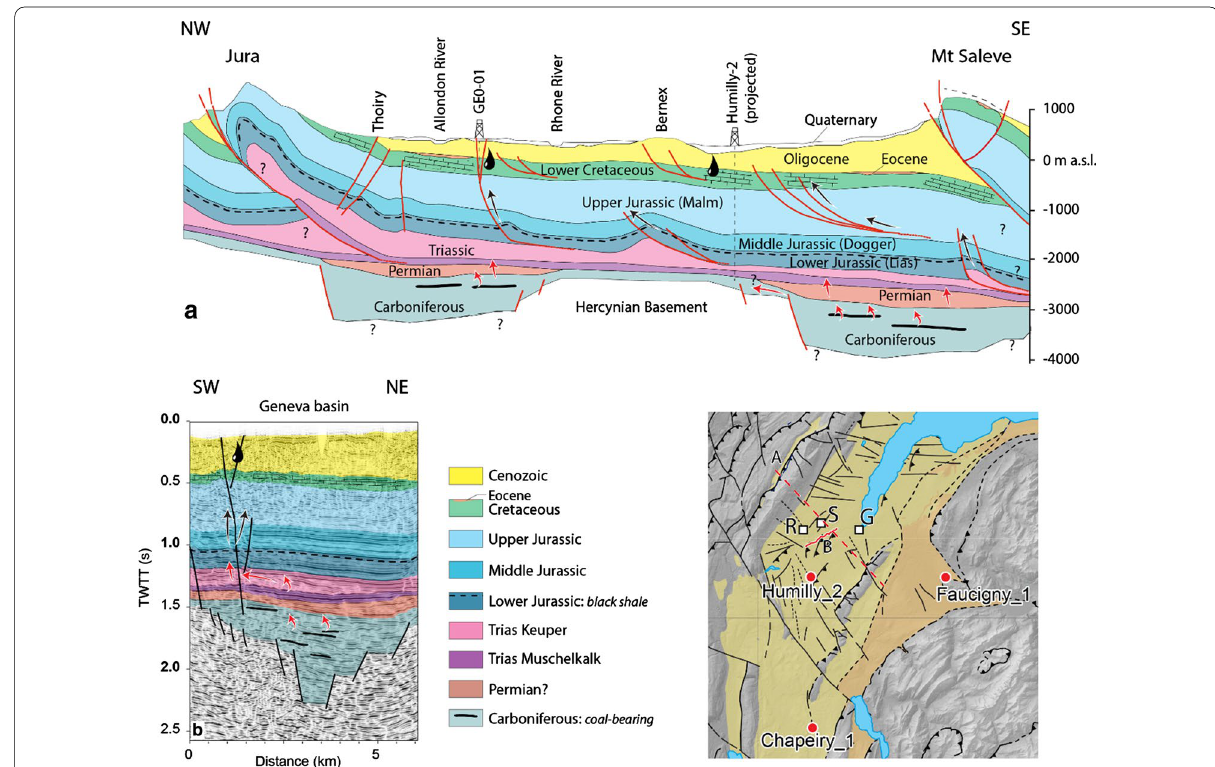
Fig. 12 Present-day petroleum system of the Geneva Basin viewed through interpreted 2D seismic lines ( a and b , located in the inset map) and showing the potential stratigraphic levels generating hydrocarbons that migrated toward stratigraphically shallower levels (modified from Moscariello, 2019). Black arrows: oil migration; red arrows: gas migration. In the map: R: Roulave, S: Satigny; G: Geneva; yellow: authoctounous Plateau Molasse; light brown: thrusted Subalpine Molasse (see Fig.